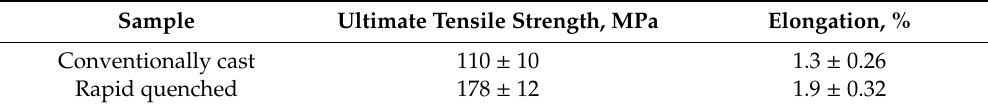
Table 2. Tensile properties of the studied Al-18%Si-2%Cu